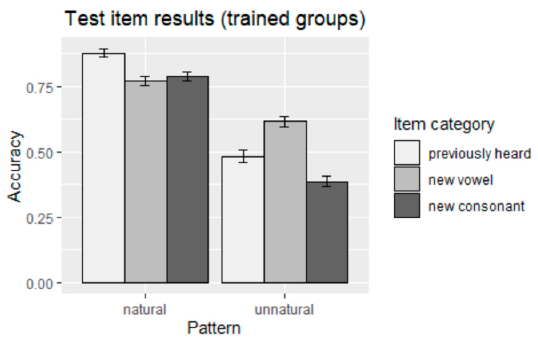
Figure 2. Accuracy of responses to test items (trained groups).